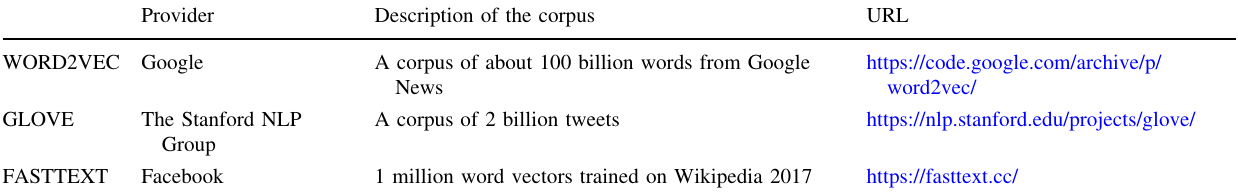
Table 1 The specification of the pre-trained models that were used for the Word2vec, GloVe, and FastText methods